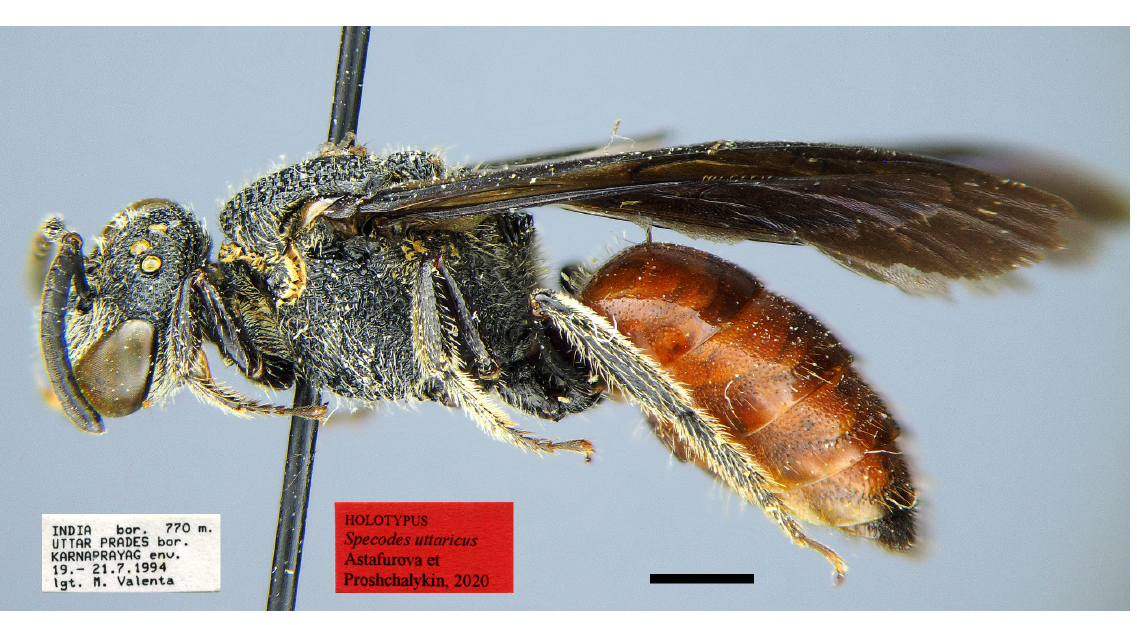
Fig. 21. Sphecodes uttaricus sp. nov. Holotype, ♀ (PCMS/OLBL). Habitus in lateral view and labels. Scale bar = 1